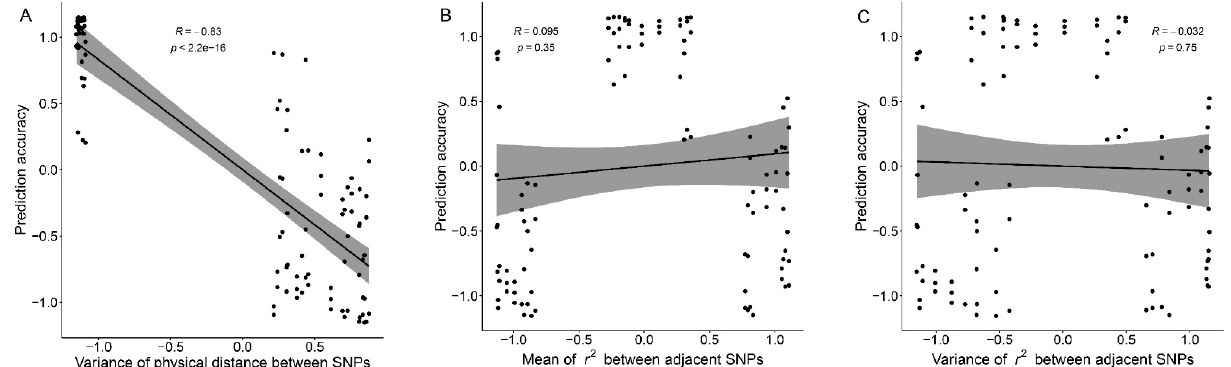
Figure 5. The correlation tests between normalized marker density-related measurements and the normalized genomic prediction accuracy. Correlation tests were performed by combining normalized marker density-related measurements and normalized GEBV accuracies at all SNP number levels. The correlation coefficient, p -value of the correlation coefficient generated by each correlation test were given in the plot. The correlation test results of variance of the physical distance between adjacent SNPs, the mean and variance of the r 2 (genetic distance) between adjacent SNPs with genomic prediction accuracy are listed in ( A – C ) respectively.